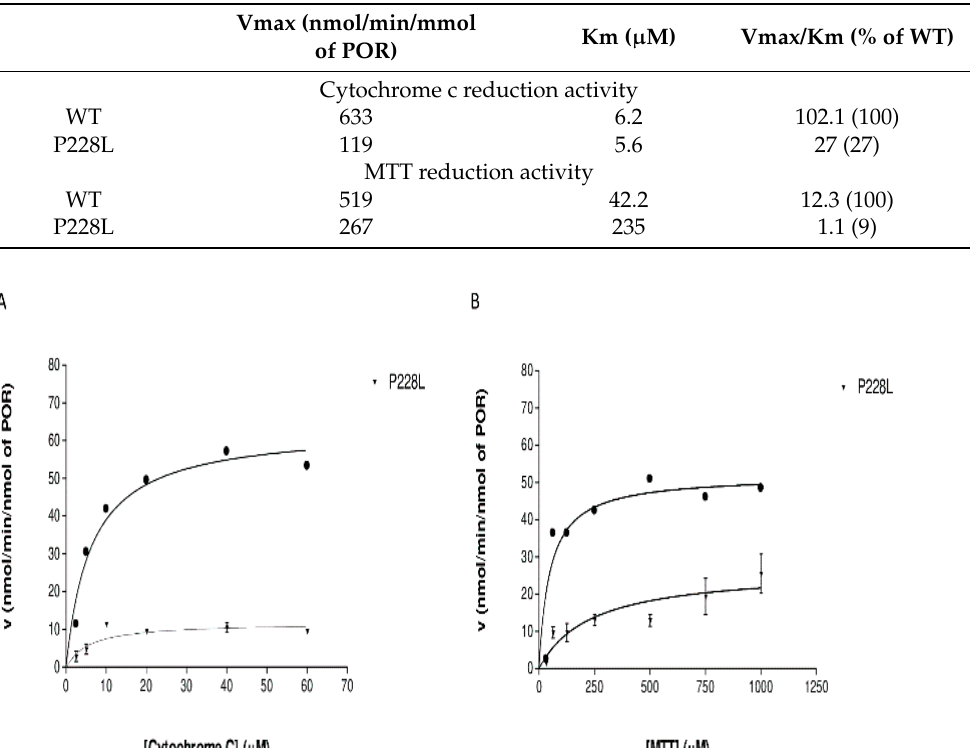
Table 3. Kinetic parameters for the reduction of model electron acceptors catalysed by recombinant WT or P228L POR. Vmax/Km was used to compare the activity of WT vs. P228L; the WT activity was set at 100%.